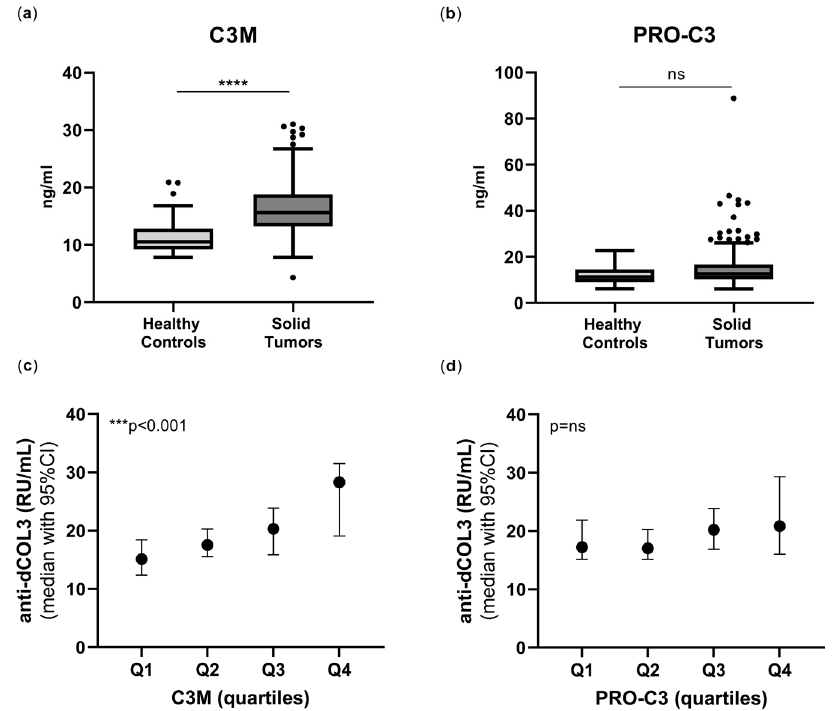
Figure 2. Type III collagen degradation (C3M) is elevated in cancer and associated with anti-dCol3. ( a ) MMP-mediated degradation of type III collagen (C3M) and ( b ) formation of type III collagen (PRO-C3) in 223 cancer patients compared to healthy controls (n = 33). Biomarker levels are presented as Tukey box plots, and statistical differences were analyzed using the Mann–Whitney test. ( c ) C3M and ( d ) PRO-C3 levels in the cancer patients were divided into quartiles, and the anti-dCol3 levels presented as median with 95% CI were compared between each quartile with a Kruskal–Wallis test adjusted for Dunn’s multiple comparisons tests. ns: non-significant, *** p < 0.001, **** p < 0.0001.